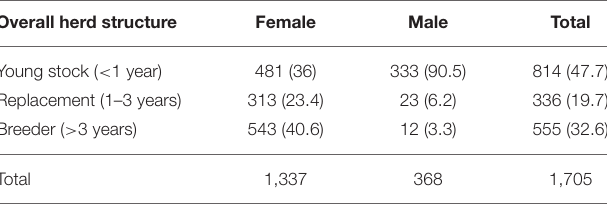
TABLE 1 | Overall cumulative herd structure categorized by sex and age class. Overall herd